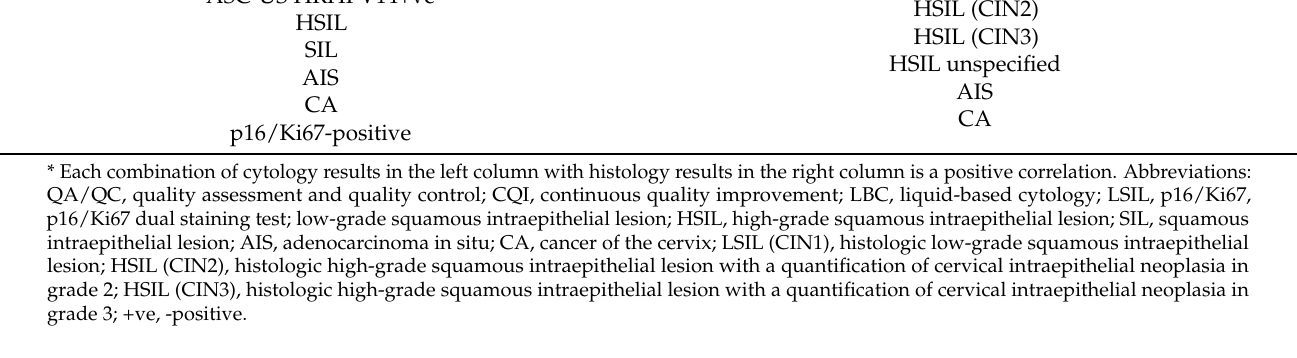
Table 2. Selected QA/QC tools used in CQI protocol-groups of negative cytologic-immunocytochemical-histologic correla- tions with modification for the study